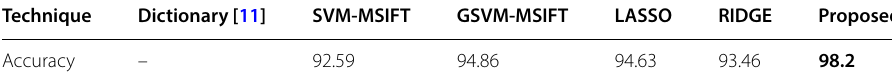
Table 7 Accuracy for different classifiers worked on PRIVATE database Technique